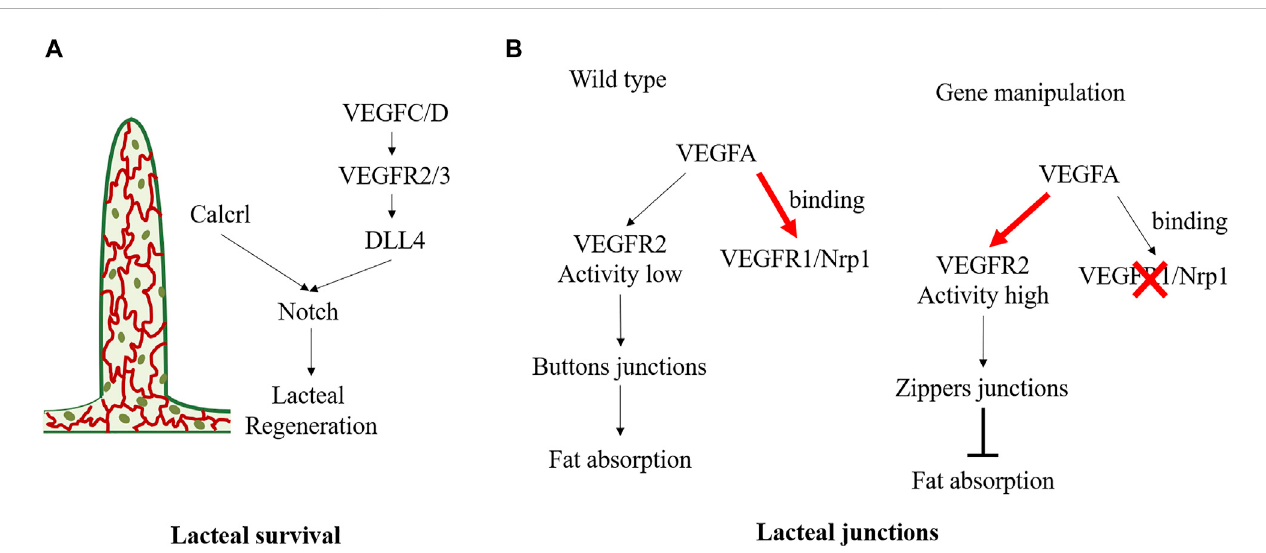
FIGURE 4 Molecular mechanisms regulating the status of lacteal survival and lacteal junctions. (A) VEGFC/D signals activate VEGFR2/3 and further promote lacteal DLL4 expression and Notch signaling. And Calcrl is also the upstream of Notch/DLL4 signaling in maintaining lacteal regeneration. (B) In physiological state, VEGFA binding to VEGFR1and Nrp1 on blood endothelial cells resulting in low VEGFR2 activity in lymphatic endothelial cell, which maintains the buttons junctions and facilitates fat absorption. Deletion of endothelial Nrp1 and VEGFR-1 results in high VEGFR2 signaling activity, leading to the formation of zippers junction and impairs fat